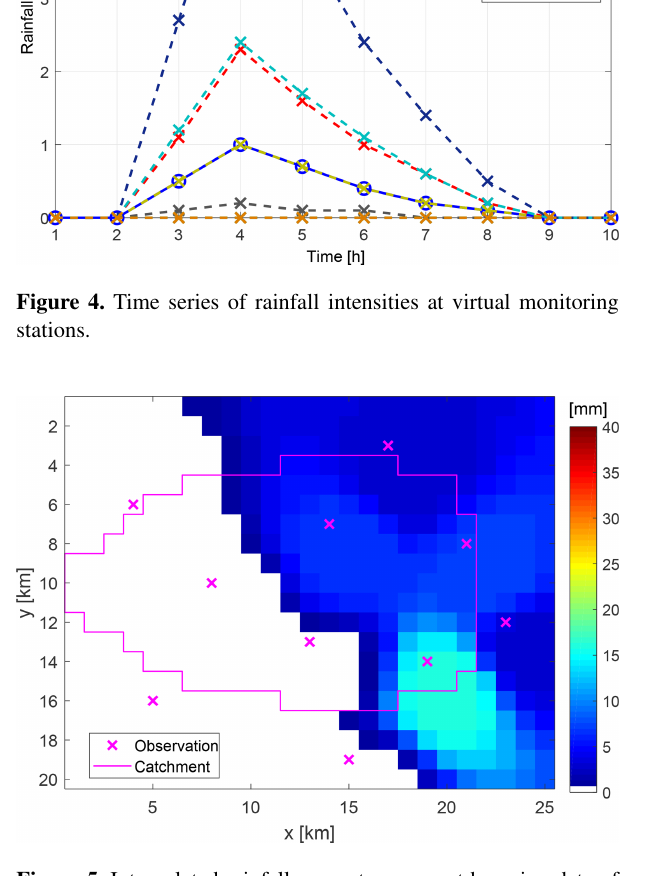
Figure 5. Interpolated rainfall amounts per event by using data of virtual monitoring stations.